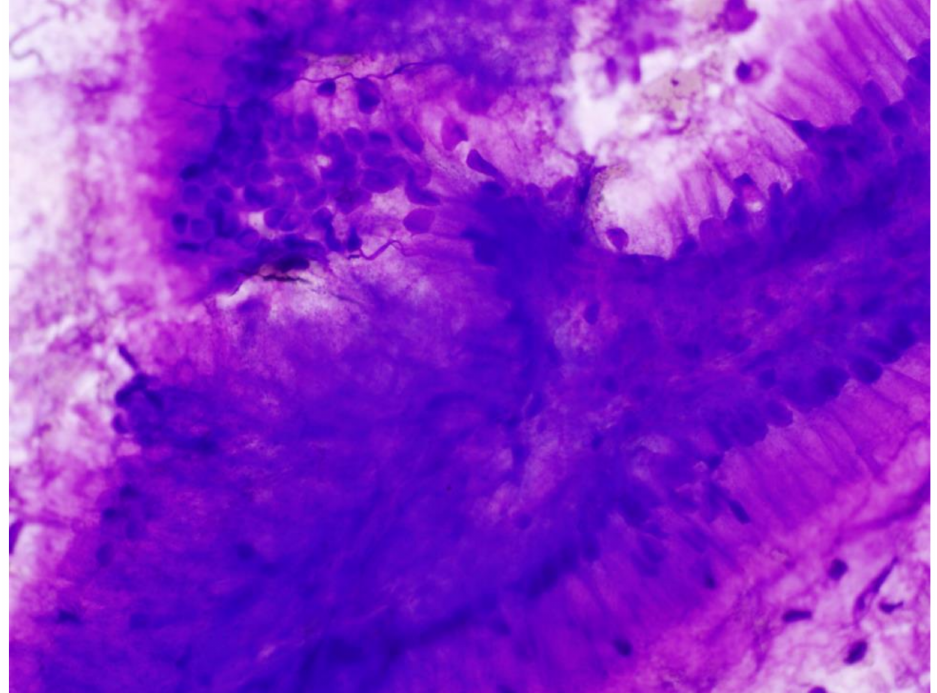
Figure 4. Papillary fragment of tissue composed of tall mucin-producing columnar cells containing bland nuclei polarized to the base of the cells. These features are characteristic of an intraductal papillary mucinous neoplasm (“Neoplasm, other”), (Diff–Quik